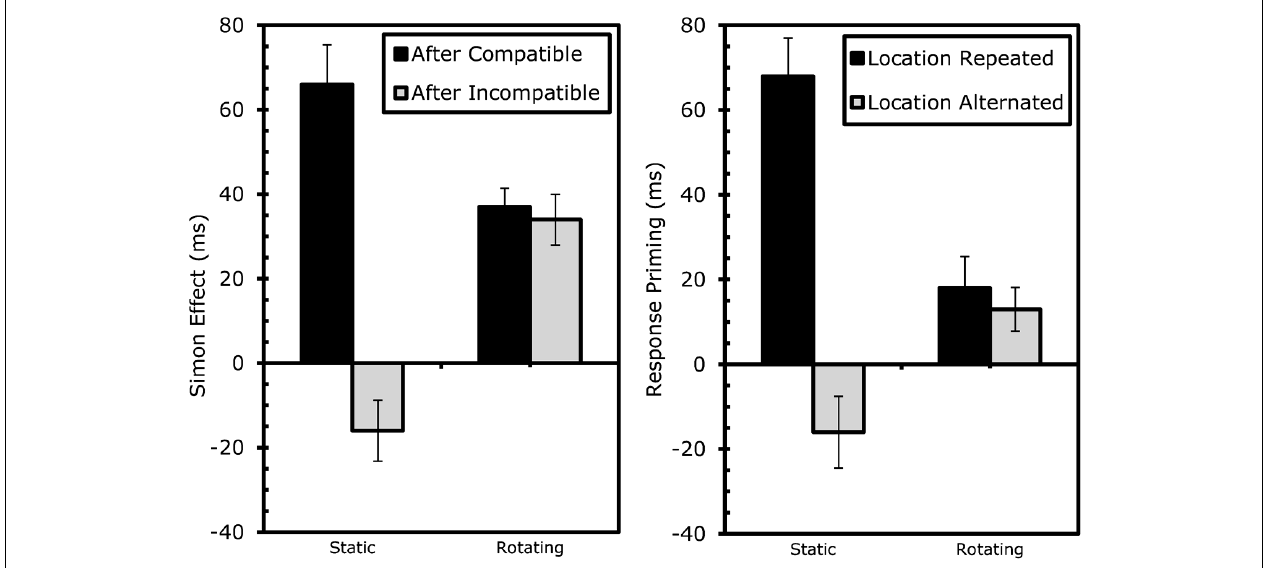
FIGURE 3 | Results Experiment 1: effects of rotation on sequential Simon effects (left) and event-coding (right). Conflict-adaptation was measured as the reduction in Simon effect after incompatibility. Event-coding effects were measured as the decrease in